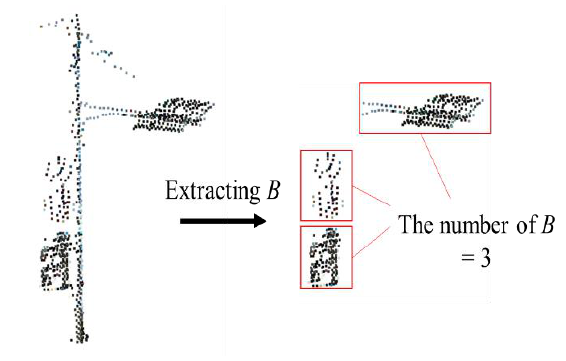
Figure 16. A signal having multiple subsets